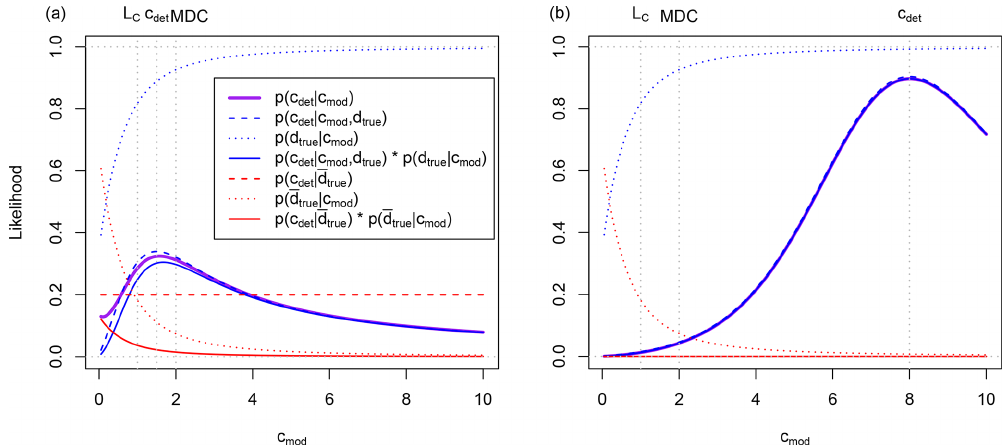
Figure 2. Likelihood function for two detections: c det = 1 . 5 (a) and c det = 8 . 0 (b) . The dotted vertical grey lines represent L C = 1 . 0, MDC = 2 . 0 and the detected activity concentration c det . The units are arbitrary in this